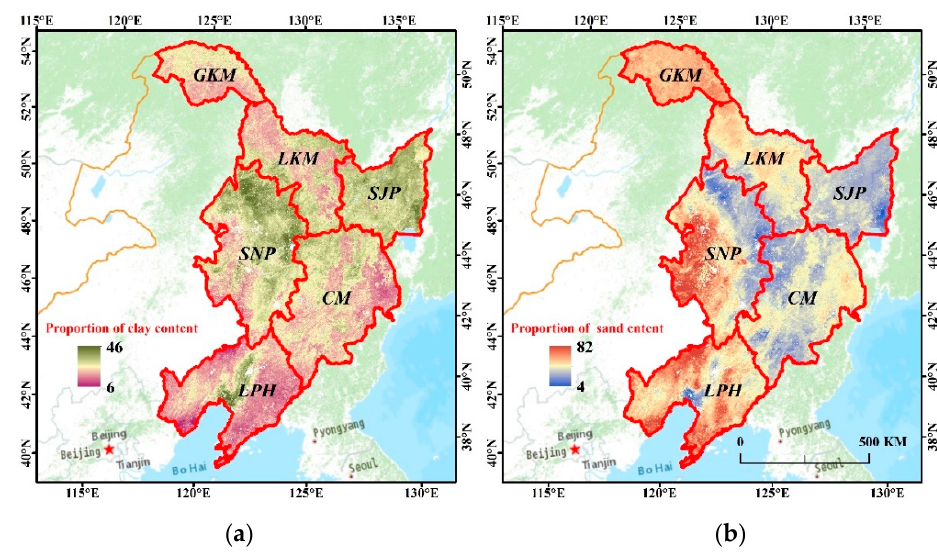
Figure 5. Proportions of clay particles ( a ) and sandy particles ( b ) in the study area.